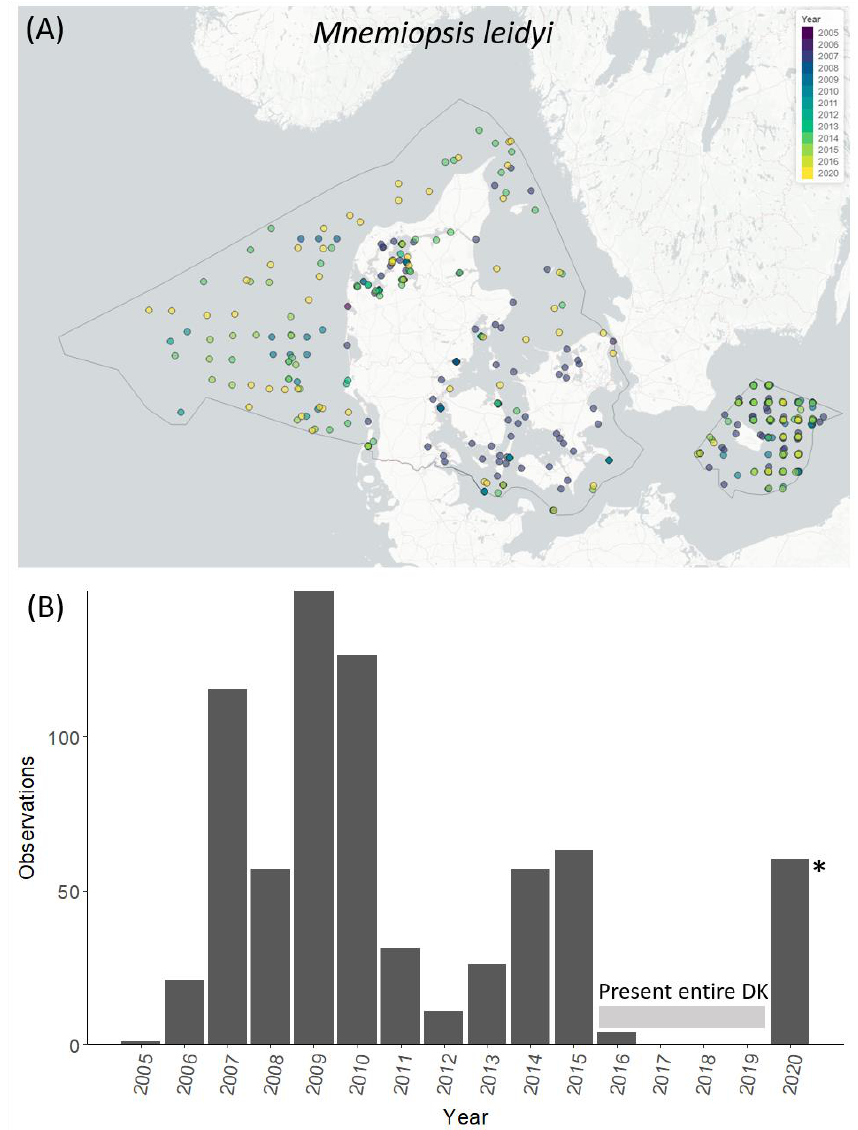
Figure 11. Mnemiopsis leidyi distribution pattern in Danish waters sorted by year ( A ) and cumulative yearly sightings ( B ). Note: time series of M. leidyi does not include observations for Danish waters from 2016 to 2019, when M. leidyi has been confirmed present across all Danish waters (C. Jaspers pers comment). * Bornholm Basin, with 45 station grids, sampled during March and November 2020, is not included.